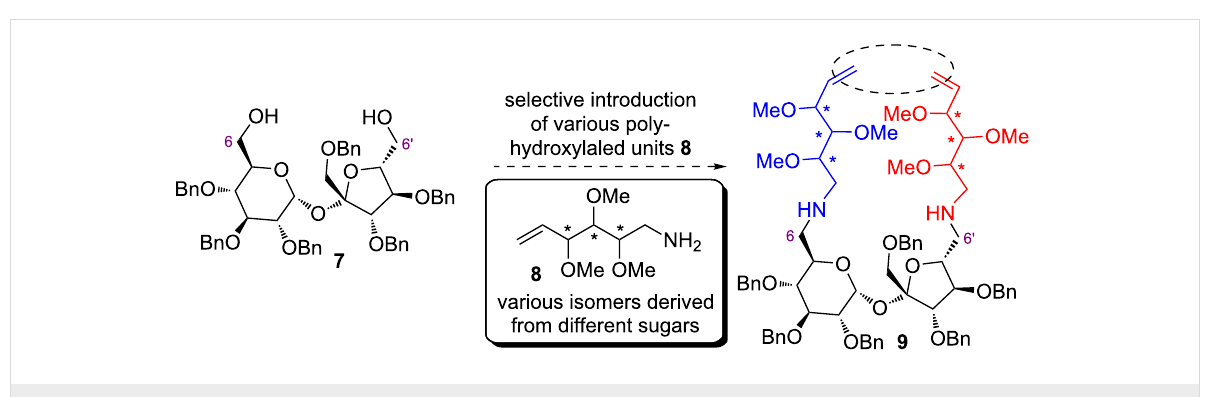
Figure 2: Possible route to dienes of type 9 .